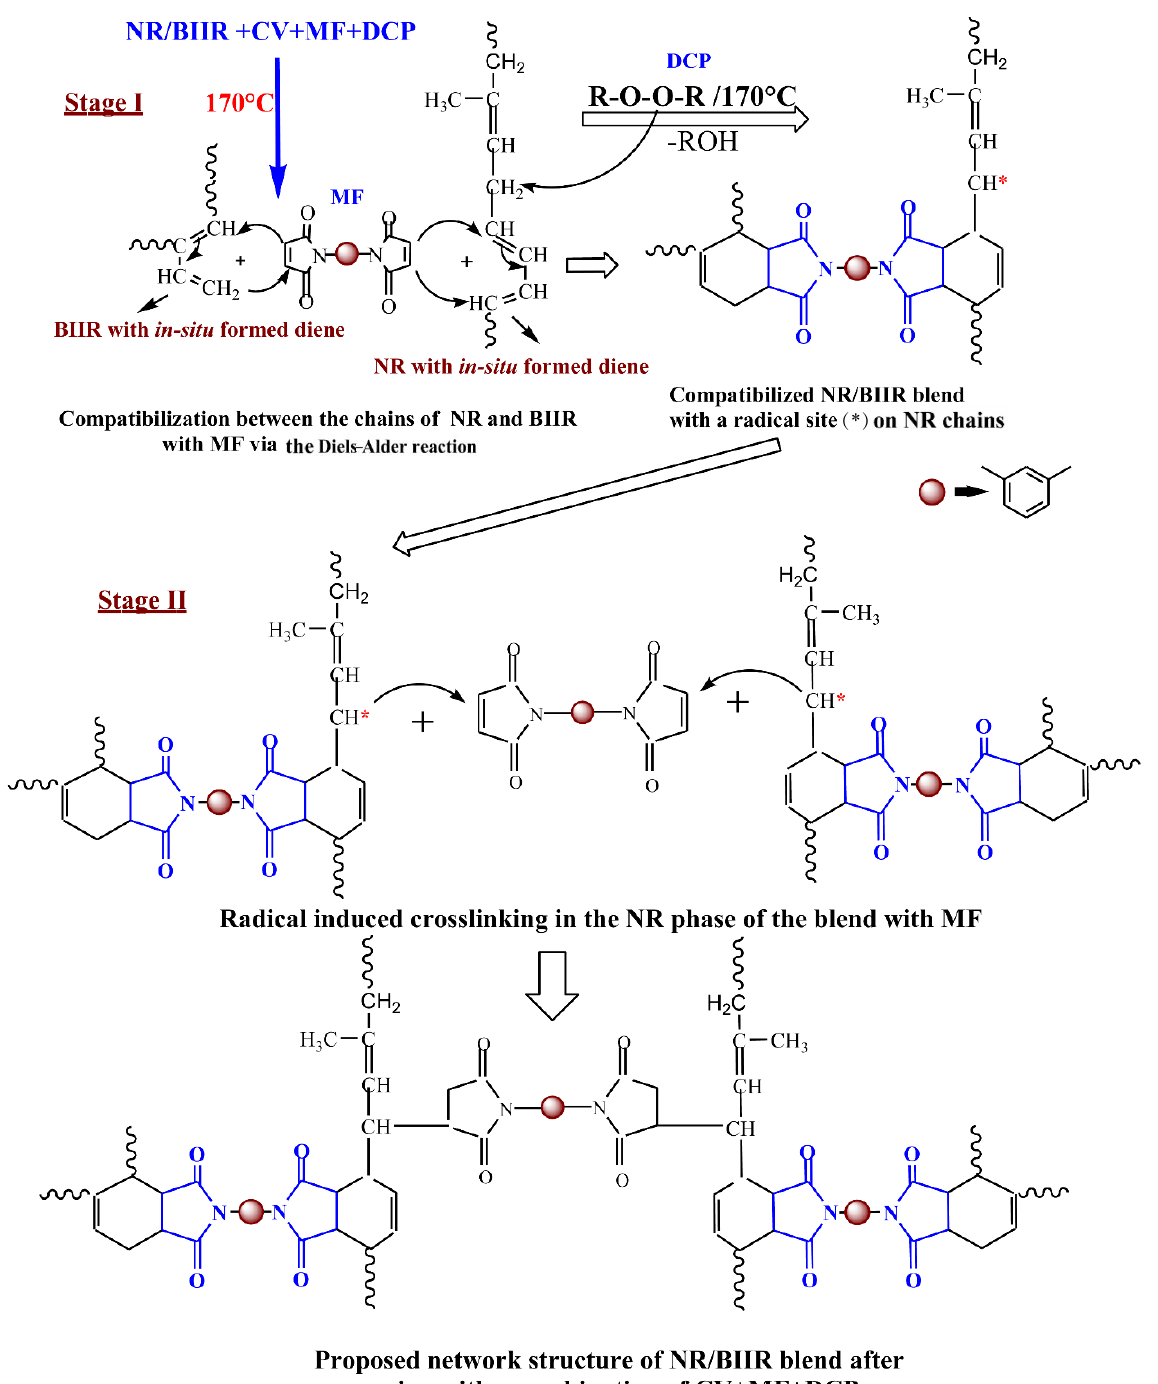
Figure 4. Plausible crosslinking mechanism responsible for the enhanced compatibility and low Figure 1. This is a figure. Schemes follow the same formatting. If there are multiple panels, they compression set properties of the NR/BIIR blend with should be listed as: ( a ) Description of what is contained in the first panel. ( b ) Description of what is contained in the second panel. Figures should be placed in the main text near to the first time they are cited. A caption on a single line should be centered.